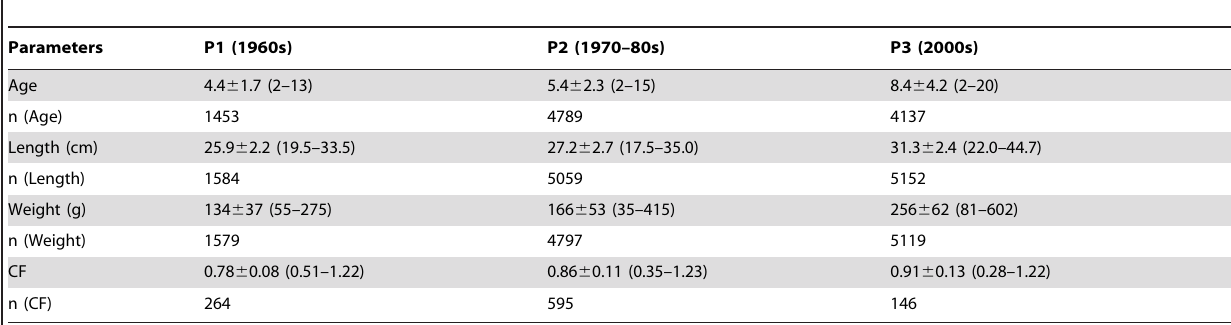
Table 2. Age, length, weight and condition factor (CF) of herring ( $ 2 year old) in the different sampling periods.